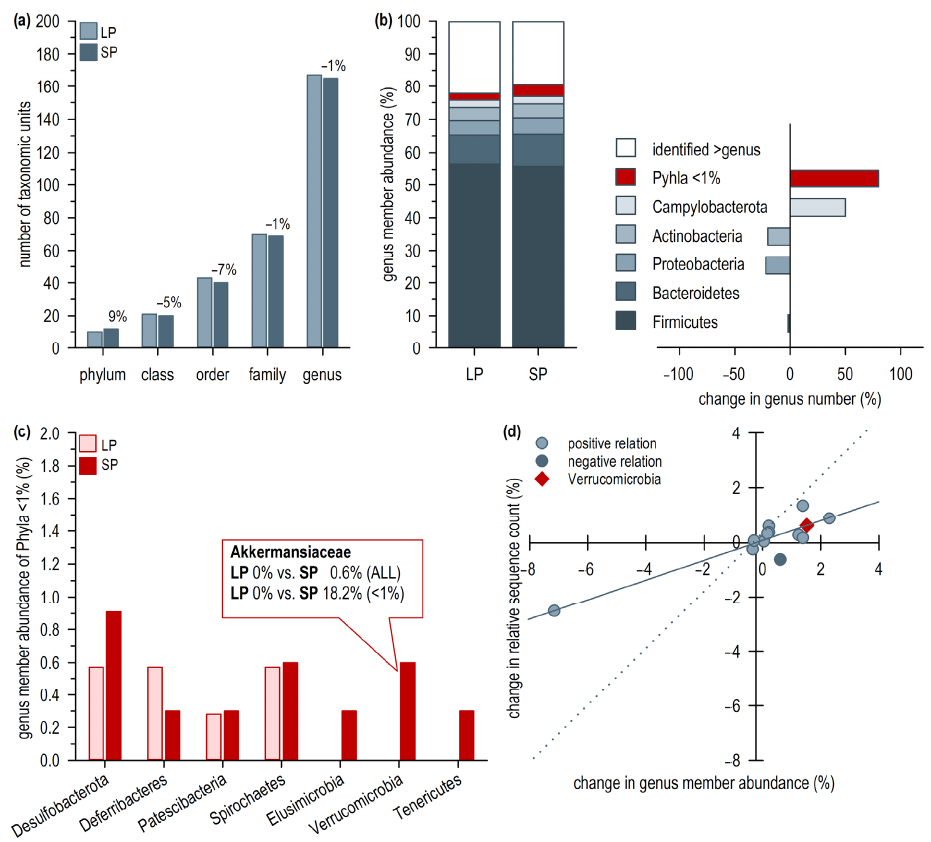
Figure 2. Microbiome composition during long photoperiod (LP) and short photoperiod (SP) exposure. Fecal samples of the same hamsters ( n = 10) were taken during LP and after twelve weeks of SP exposure, whereby the individual samples were pooled to one LP and one SP sample. ( a ) Absolute number of di ff erent taxonomic units which could be identi fi ed to genus level in the LP and SP sample. Numbers above the columns represent the relative change in taxonomic unit number after twelve weeks of SP acclimation. ( b ) Relative abundance of genus members per phylum in LP and SP. Phyla with a relative abundance of ≥ 1% in LP are depicted separately, phyla with a relative abundance of <1% are summarized. ( c ) Relative abundance of genus members in the phyla <1% comparing the LP and the SP sample. The abundance of the Verrucomicrobia increased signi fi cantly in the SP sample (Chi 2 test, χ 2(1) = 17.6, p < 0.001). ( d ) SP-induced change in relative sequence count per phylum related to change in genus member abundance. A positive relation, i.e., phyla in the fi rst and third quadrant, indicates that the relative sequence count increased or decreased together with the genus member abundance. A negative relation, i.e., phyla within the second and fourth quadrant (dark circle), shows that sequence count and genus member abundance change in opposite direction. The diamond marks the Verrucomicrobia including the Akkermansiacaeae. The lines mark a signi fi cant correlation between change in relative sequence count and genus member abundance, including all phyla (solid line; Spearman Rank Correlation, r (13) = 0.7, p = 0.014) and only positively related phyla (dashed line; Spearman Rank Correlation, r (13) = 0.8, p < 0.001). The Firmicutes were an exception, as their genus member abundance increased by 0.6% while their respective relative sequence count decreased by 0.6% (Figure 2d). The